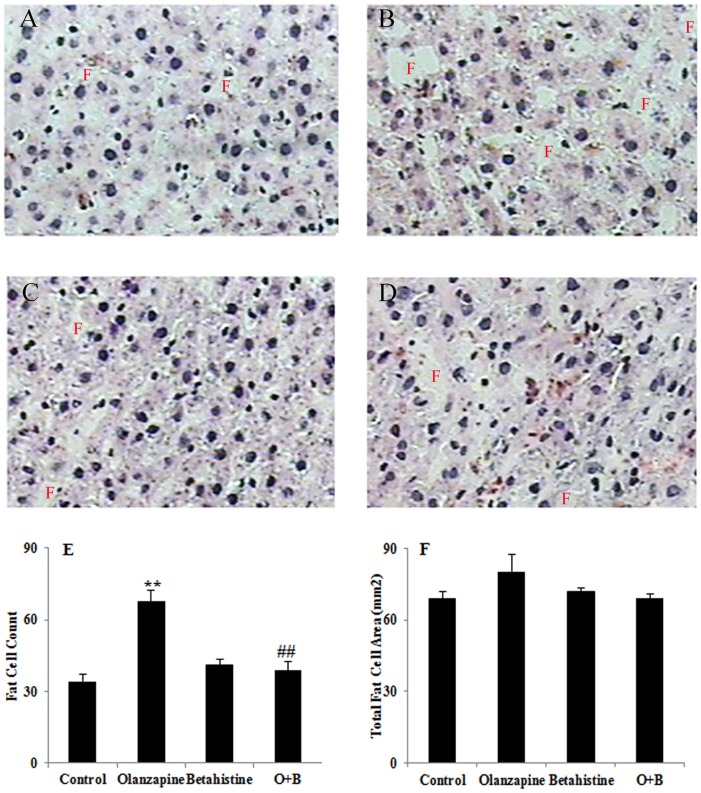
Effects of olanzapine and/or betahistine treatment (n = 12) on lipid droplet deposition of hepatic tissue.A–C: HE staining of hepatic tissue from rats treated with Vehicle (A), Olanzapine-only (B), Betahistine-only (C), and O+B co-treatment (D). E: Fat cell counts on the liver sections of different treatment groups. F: Total fat cell area measured on the liver sections of different treatment groups. ** p<0.01 vs. control; ## p<0.01 vs. olanzapine.